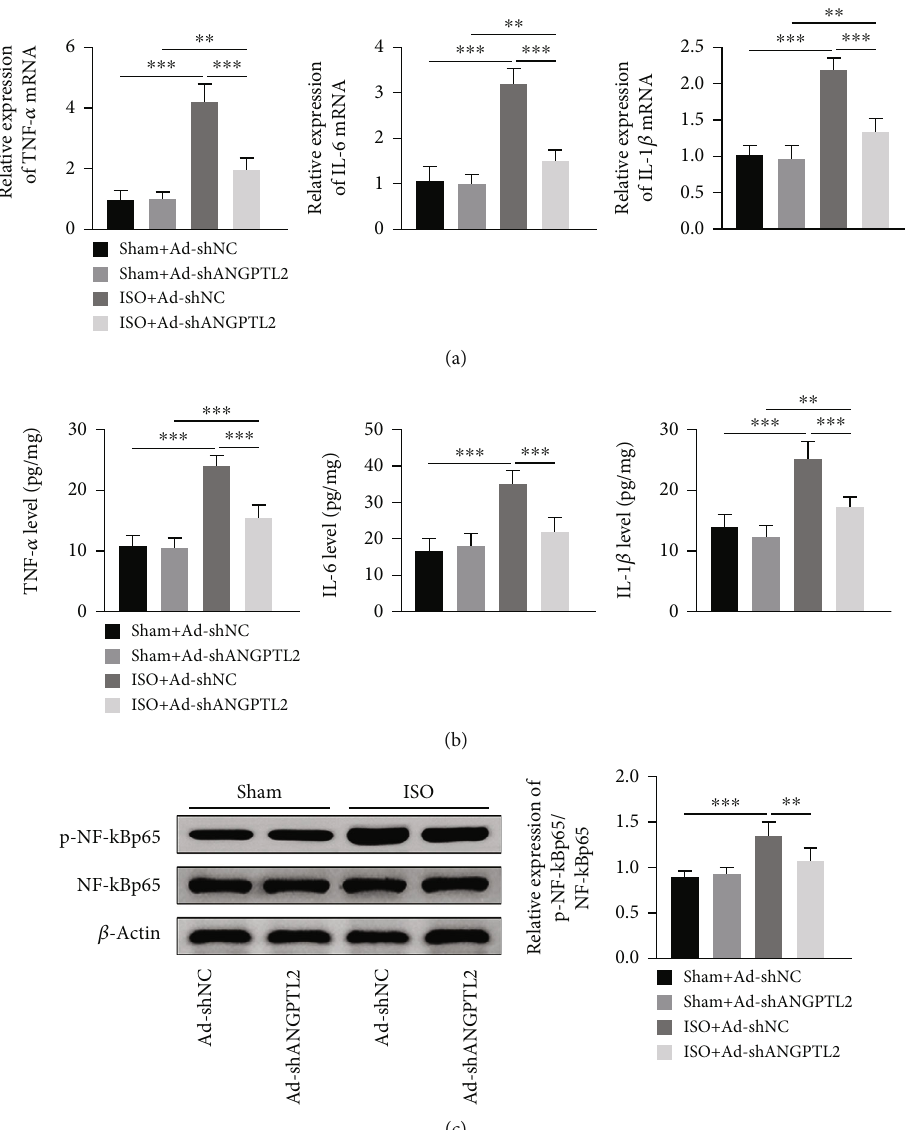
Figure 3: Downregulation of ANGPTL2 suppressed iso fl urane-induced in fl ammation in mice. (a) TNF- α , IL-6, and IL-1 β mRNA levels were detected using qRT-PCR. (b) ELISA was used to examine TNF- α , IL-6, and IL-1 β levels in brain tissues. (c) Western blotting was used to measure p-NF- κ B p65, NF- κ B p65, and β -actin protein levels. n = 6 . ∗∗ p < 0 : 01 ; ∗∗∗ p < 0 : 001